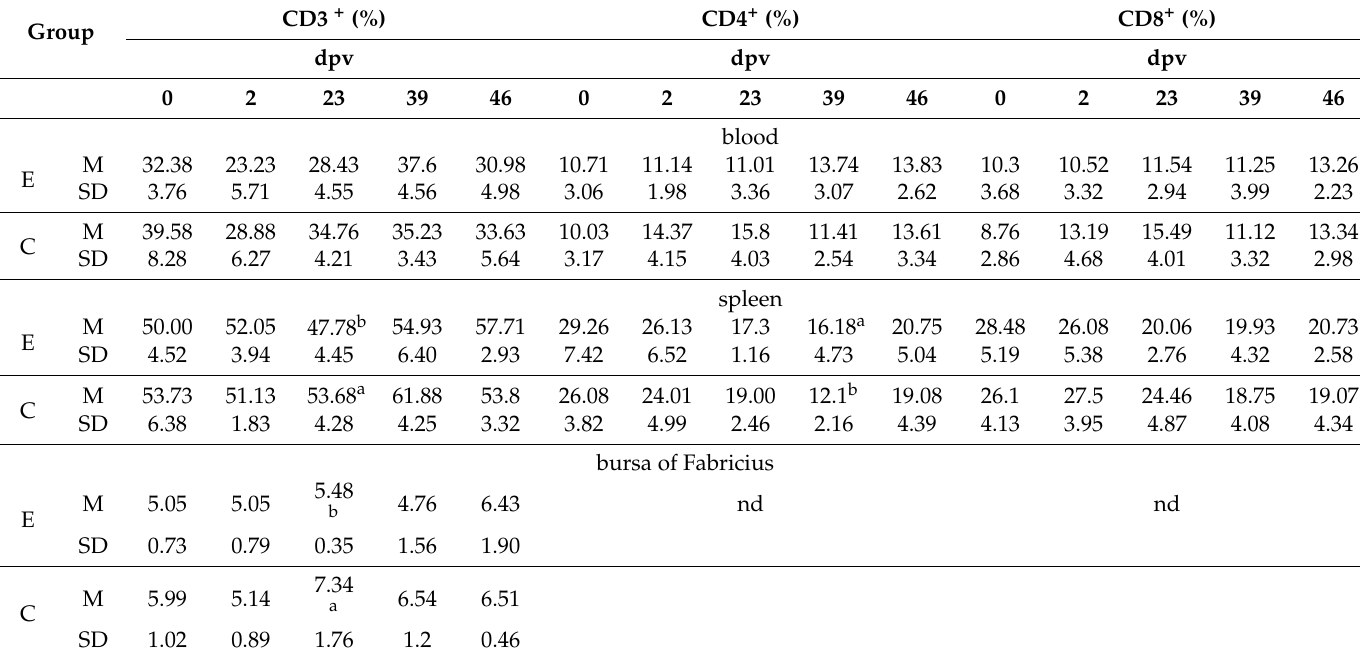
Table 2. The percentage of T CD3 + , CD4 + and CD8 + lymphocytes in the blood, spleen and bursa of Fabricius samples collected from the examined pigeons. Abbreviations: dpv—days post first immunization, M—mean, SD—standard deviation, nd—not determined, E—experimental group (immunized with PiCV rCP mixed with adjuvant), C—control group (immunized with adjuvant only. The values in the same column with different superscripts (a, b) differ significantly at p < 0.05 in U Mann-Whitney non-parametric